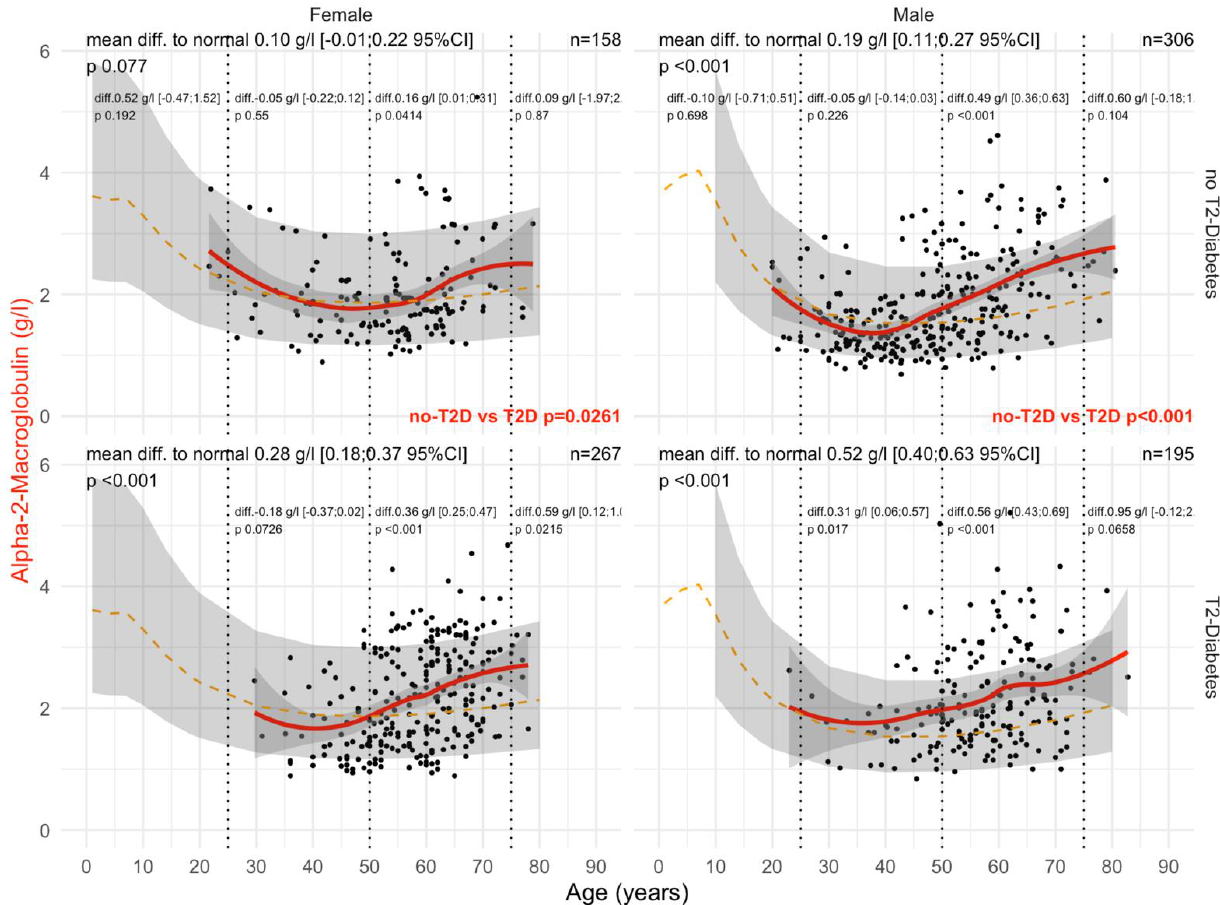
Figure 2. A2M levels in all “NAFLD-Biopsy” patients. Impact of T2DM on A2M concentration in all “NAFLD-Biopsy” patients (n = 926). Normal serum mean values according to age and sex (dashed–orange lines), with 95% confidence intervals (light-gray ribbon). Three vertical dotted lines mark the four age groups (before 25 years, between 25 and 50 years, between 50 and 75 years, and above 75 years old). Each point is a patient’s protein value. The red curve is a Loess regression of the median A2M value, along with its 95% confidence interval (darker gray). For each age group, the mean difference (%95CI) between the patient protein value and the expected normal value (for age and sex) with its significant p -value is displayed at the top of the figure. The significance between the non-T2DM and T2DM patients is displayed in red between the two panels.